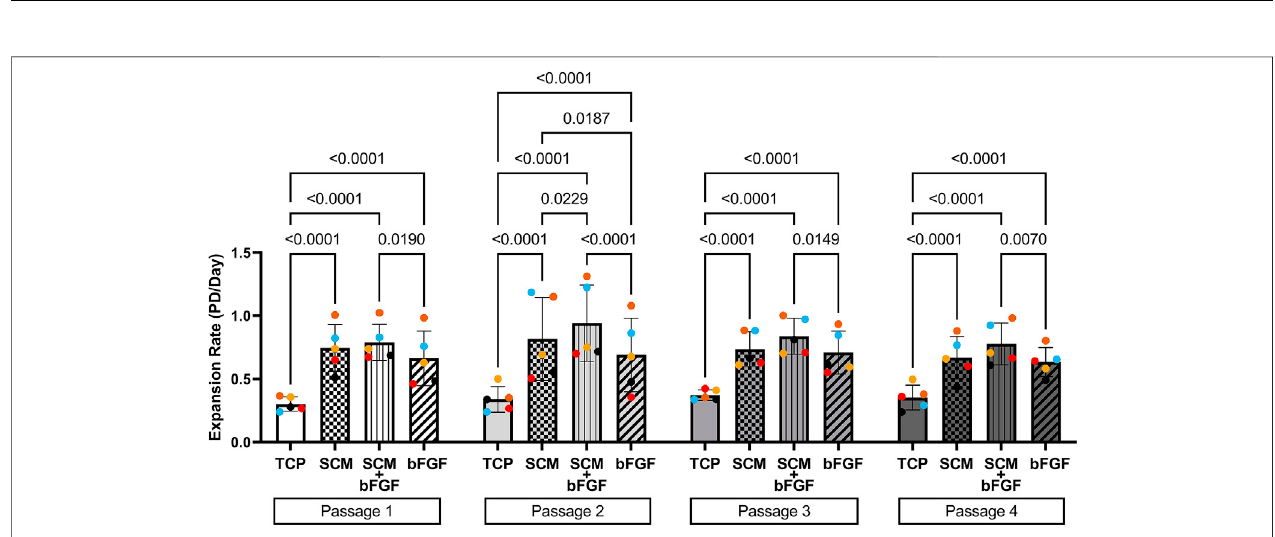
FIGURE 2 | Expansion of human chondrocytes. Human chondrocytes from fi ve donors (each color represents a donor) for four passages on tissue culture plastic (TCP), synoviocyte-derived extracellularmatrix (SCM),on synoviocyte matrix withbFGF(SCM +bFGF),oron tissue culture plastic withbFGF(FGF). p < 0.05 areshown, two-way ANOVA.